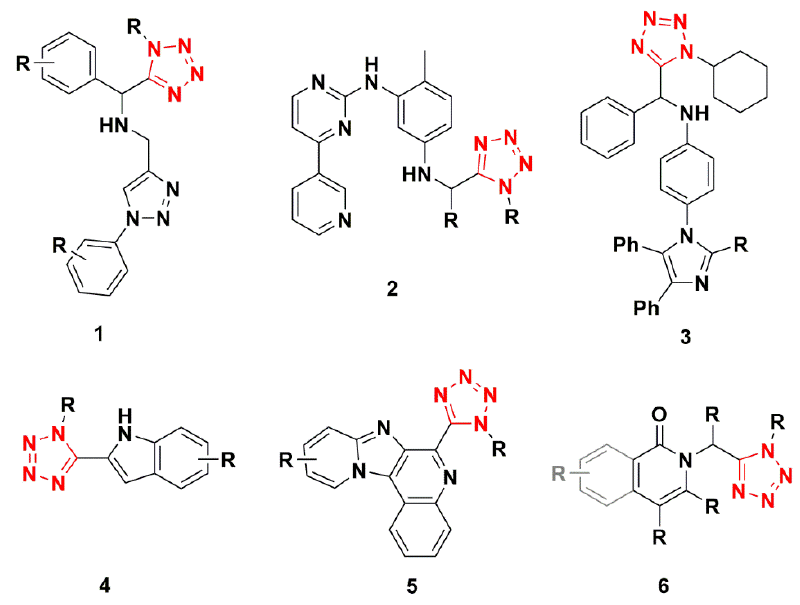
Figure 1. Examples of some hybrids systems containing a 1,5-DS-T moiety via Ugi-azide reaction.